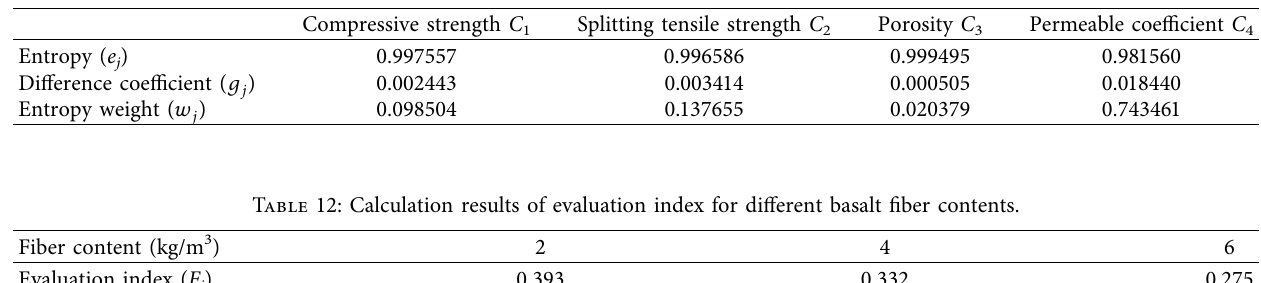
Table 11: Entropy weight calculation results of diferent basalt fber contents.